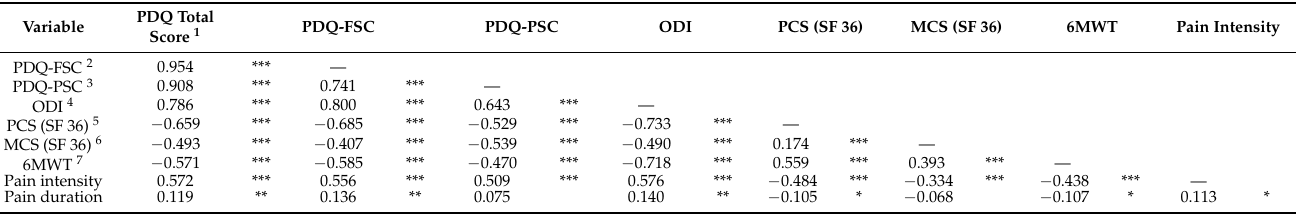
Table 5. Correlations among clinical variables ( N = 480).